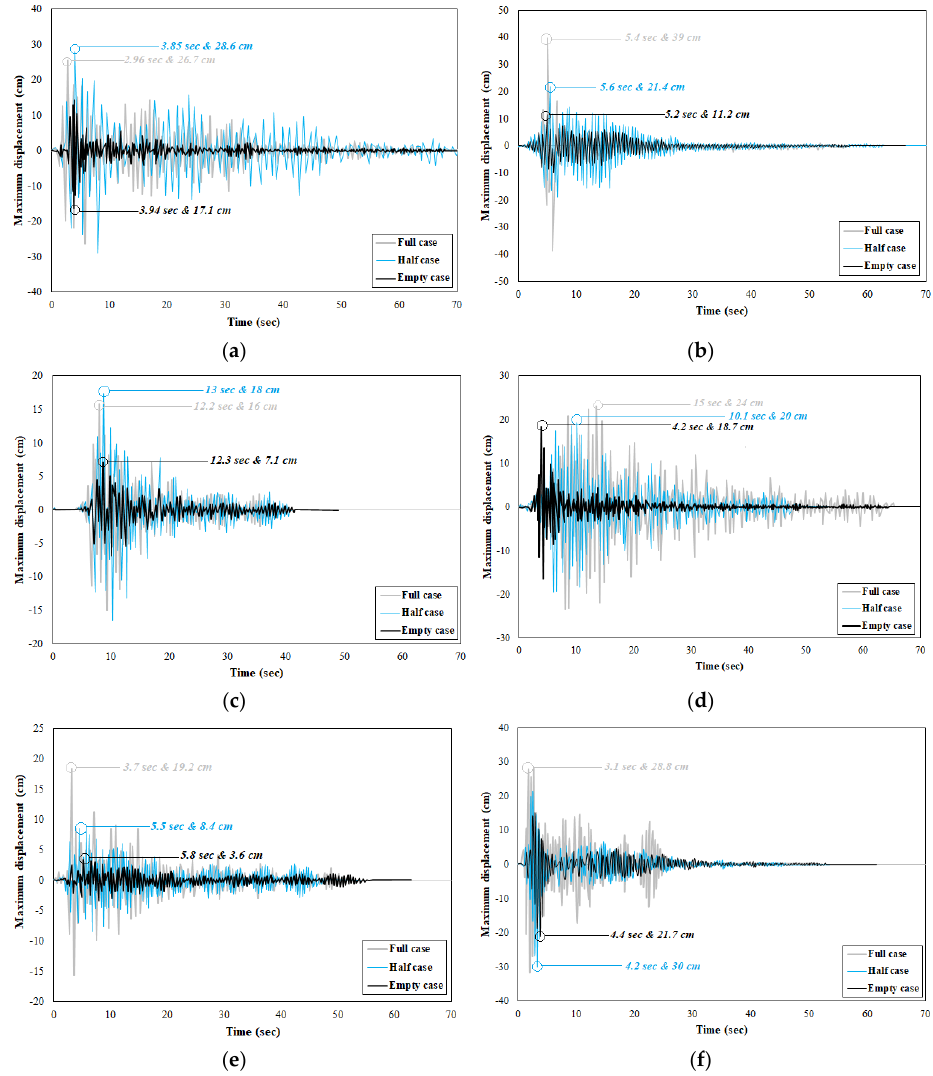
Figure 14. Time history of maximum displacement under various far-fault ground motions: ( a ) Imperial Valley, ( b ) Kobe, ( c ) Kocaeli, ( d ) Loma Prieta, ( e ) Northridge, and ( f ) El Centro.